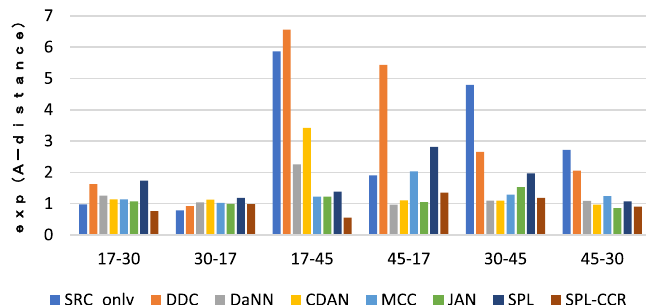
Table 4 Experimental data for classification with limited samples Number of training samples in the source domain